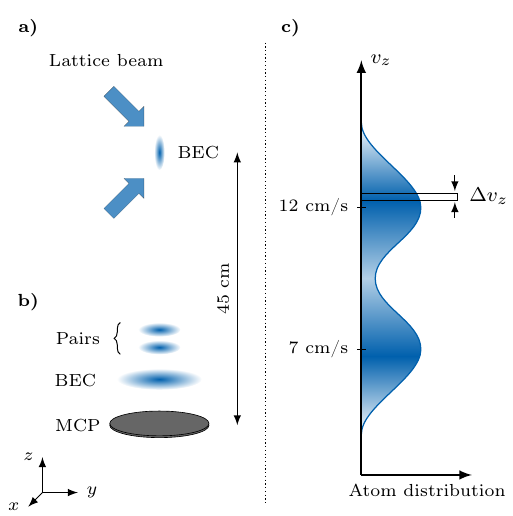
Figure 1: Diagram of the experiment. a) Atoms are emitted in pairs from a BEC confined in an optical dipole trap and subject to a moving, one-dimensional optical lattice. b) After switching off the lattice and the trap, the BEC and the clouds con- taining the pairs fall on the MCP detector as shown. c) We show schematically a vertical slice of the atomic velocity distribution in the clouds. The vertical axis shows the velocity relative to the BEC. We select small sections of one of these clouds and histogram the number of detected atoms over many repetitions.